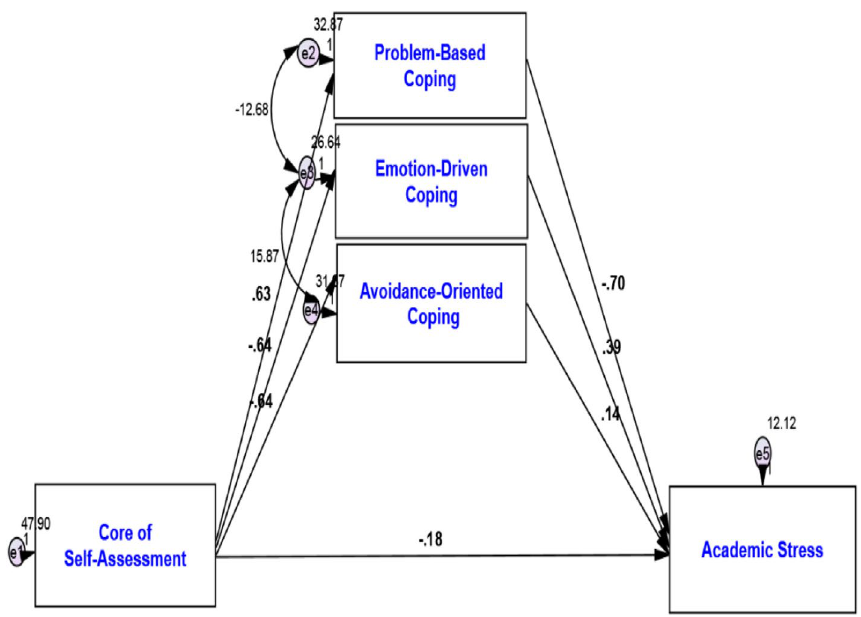
Fig. 3 Model fit in nonstandard estimation mode